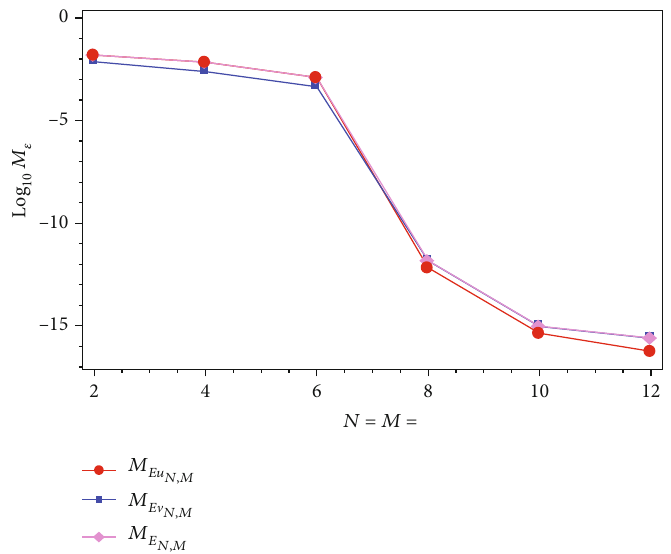
Figure 4: M E convergence of Equation (32).